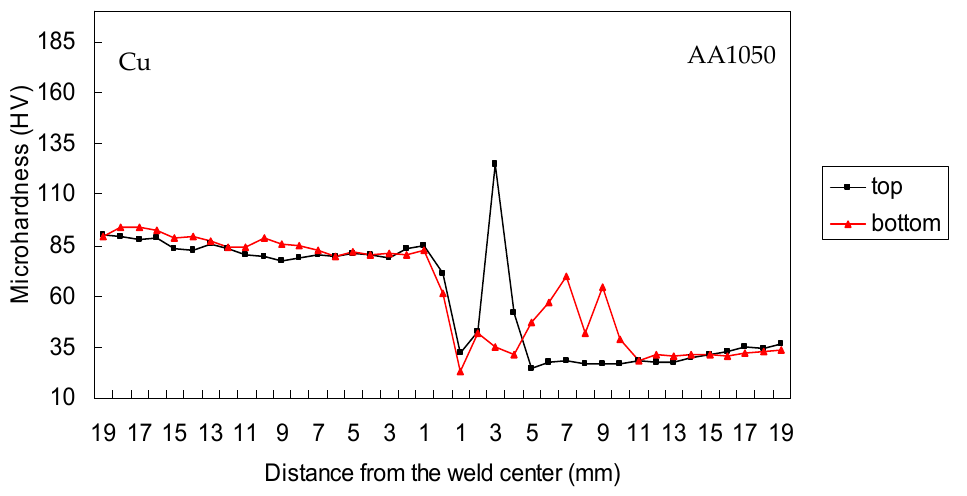
Figure 14. Hardness profile on the transverse cross section of the 2440/30/1 specimen.